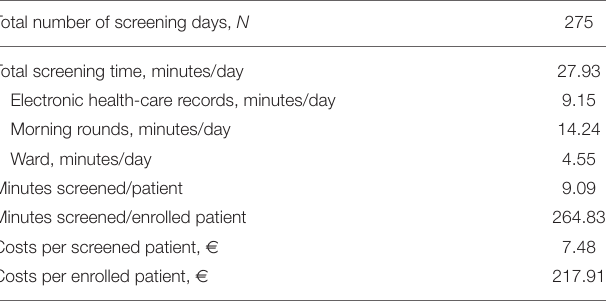
TABLE 3 | Time investment and costs related to